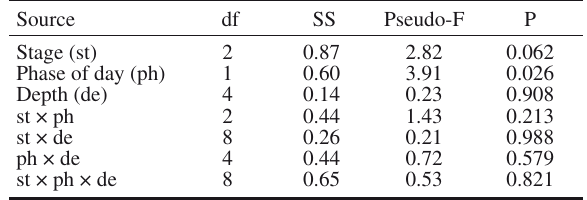
Table 1. – Monodaeus couchi . Results of the three-way PER- Table 2. – Monodaeus couchi . Results of the three-way PER- MANOVA analysis comparing the distribution of the larval stages MANOVA analysis comparing the distribution of the larval stages (4 levels: ZI, ZII, ZIII and ZIV) with respect to the phase of the day (3 levels: ZI, ZII, and ZIII) with respect to the phase of the day (2 (2 levels: day and night) and depth (6 levels: 25, 75, 125, 175, 225 levels: day and night) and depth (5 levels: 25, 75, 125, 175, and and 275 m) in 2006. 225 m) in 2007.